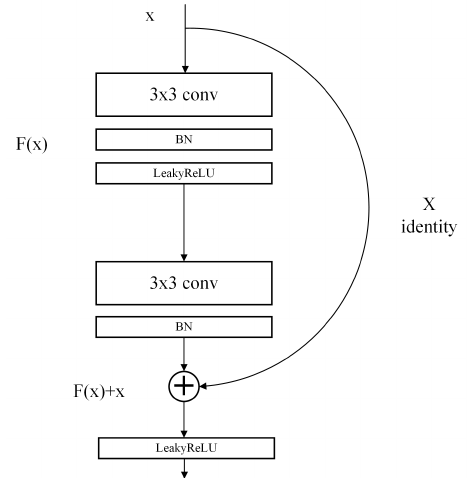
Figure 8. Two-layer residual